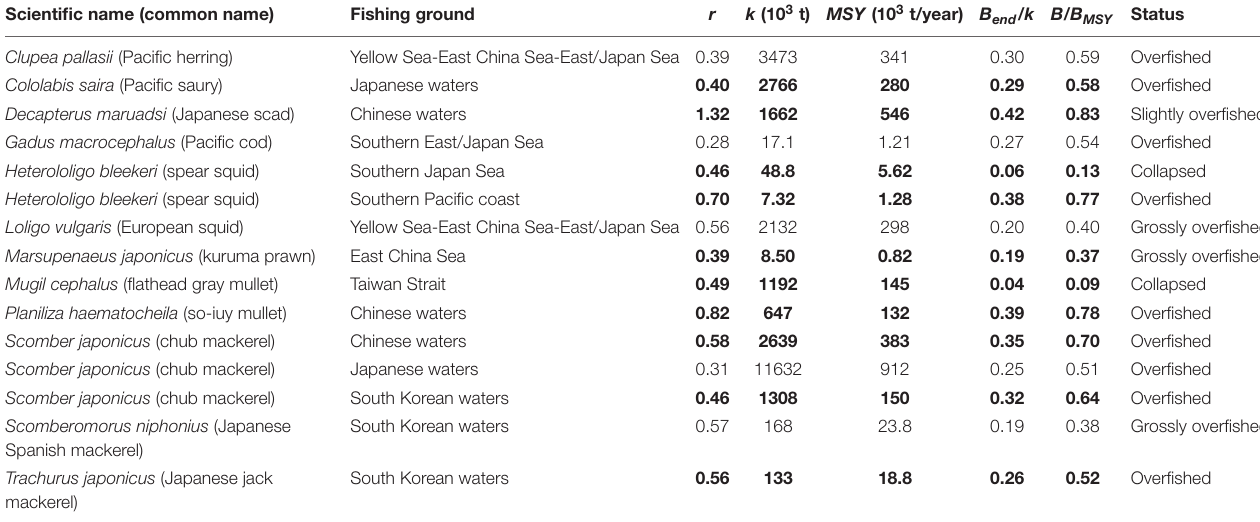
Those not in bold are based on the catch data by CMSY).